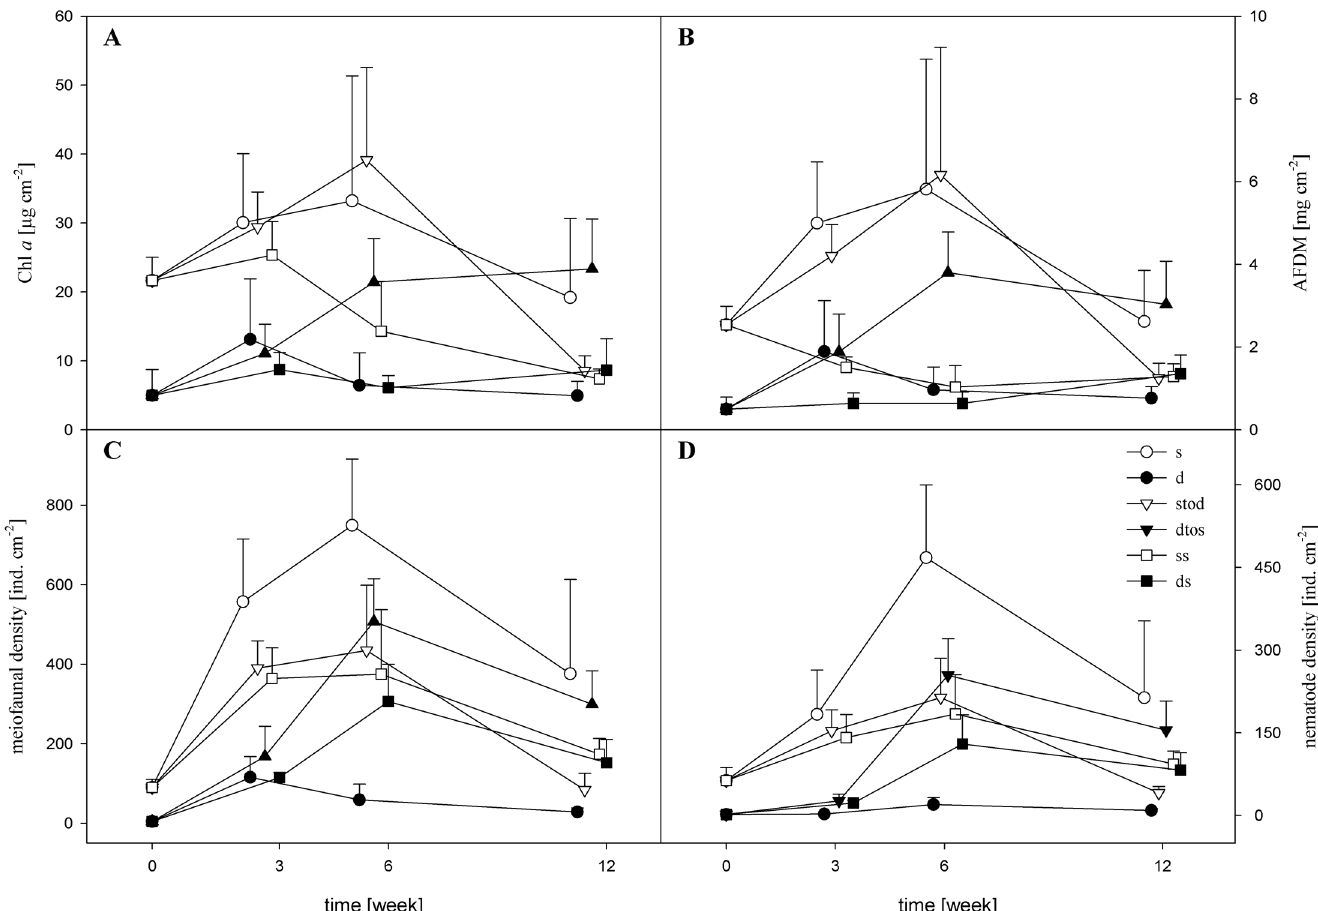
Fig 1. Dynamics of (a) phototrophic biomass measured as chlorophyll a (Chl a ) concentration, (b) organic matter content measured as ash-free dry mass (AFDM), (c) meiofaunal density, and (d) nematode density in the periphyton of Lake Erken. Data (mean, n = 5, +SD) are given for six different depth treatments (s: shallow, d: deep, s to d: shallow-to-deep, d to s: deep-to-shallow, ss: shallow-shaded, and ds: deep-to-shallow-shaded).